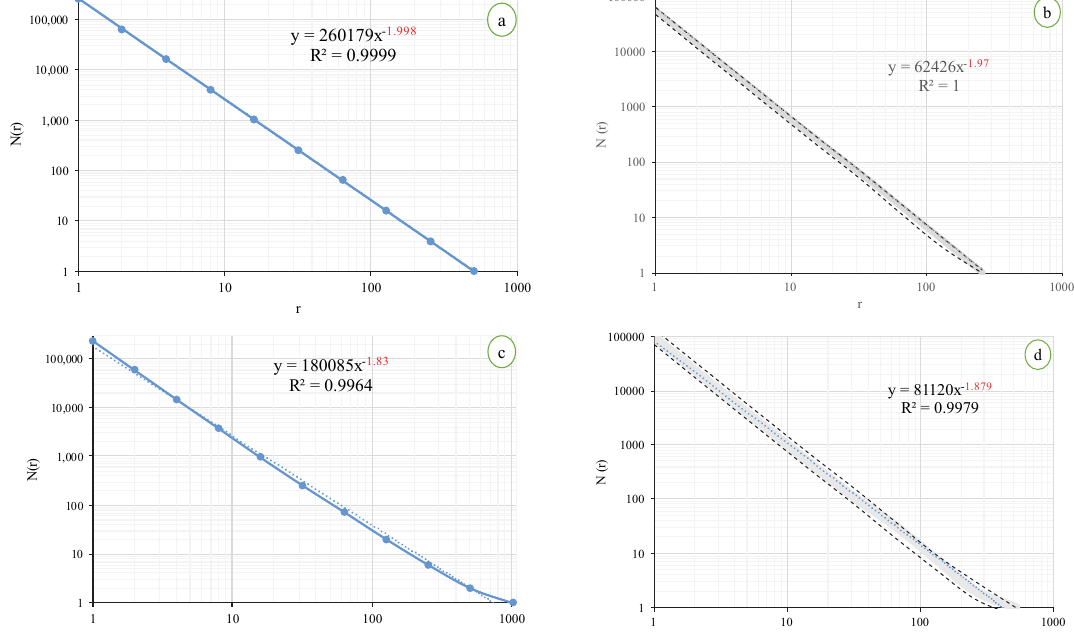
Figure 6: The log-log size-frequency of fracture in two studied areas for two scales; a) the results of field surveying for Region 1, b) the results of CT-scan of core samples for region 1, c) field surveying for region 2, d) CT-scan of core samples for region